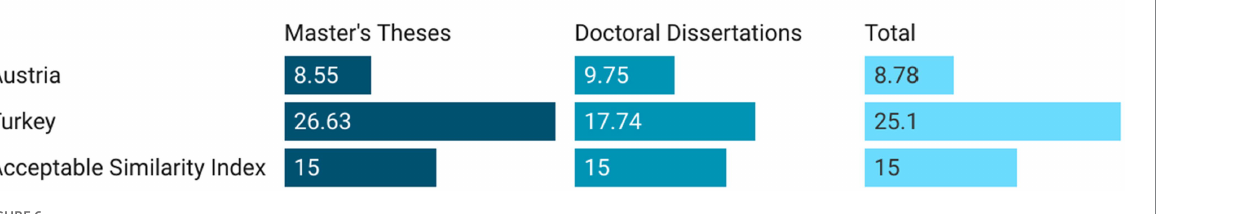
FIGURE 6 Average similarity indexes of Austria and Turkey.